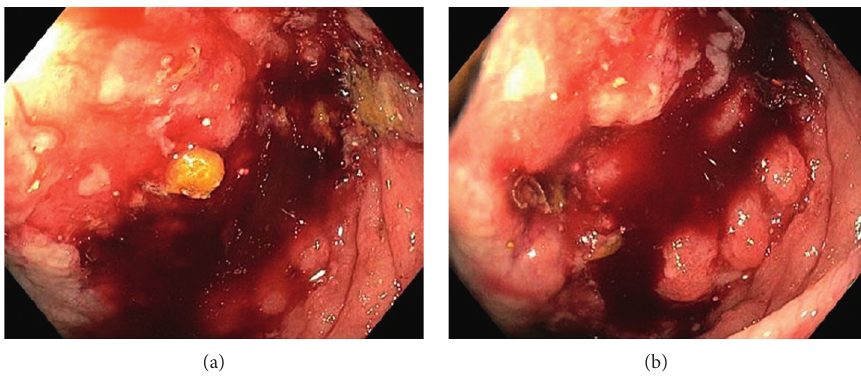
Figure 2: Severe colitis localized at the cecum with friable mucosa.